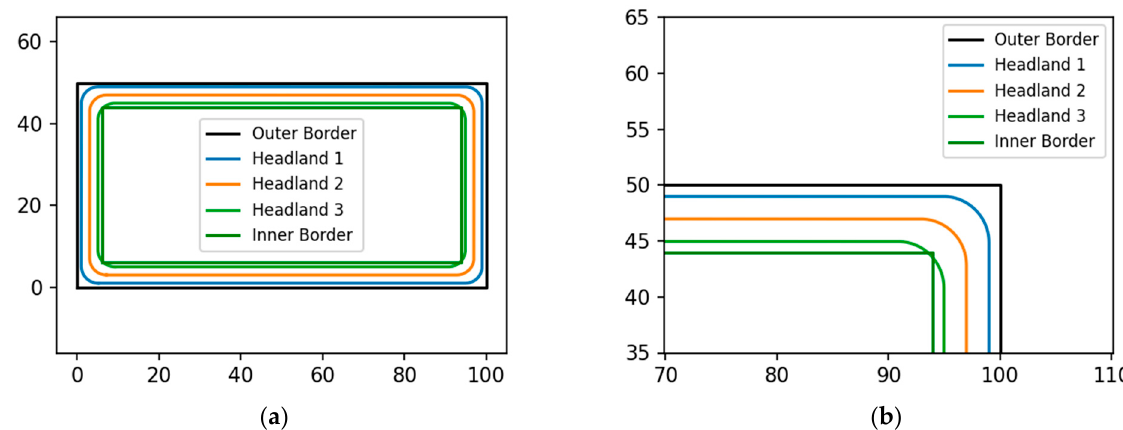
Figure 6. (a) Inner boundary (red); (b) Inner boundary